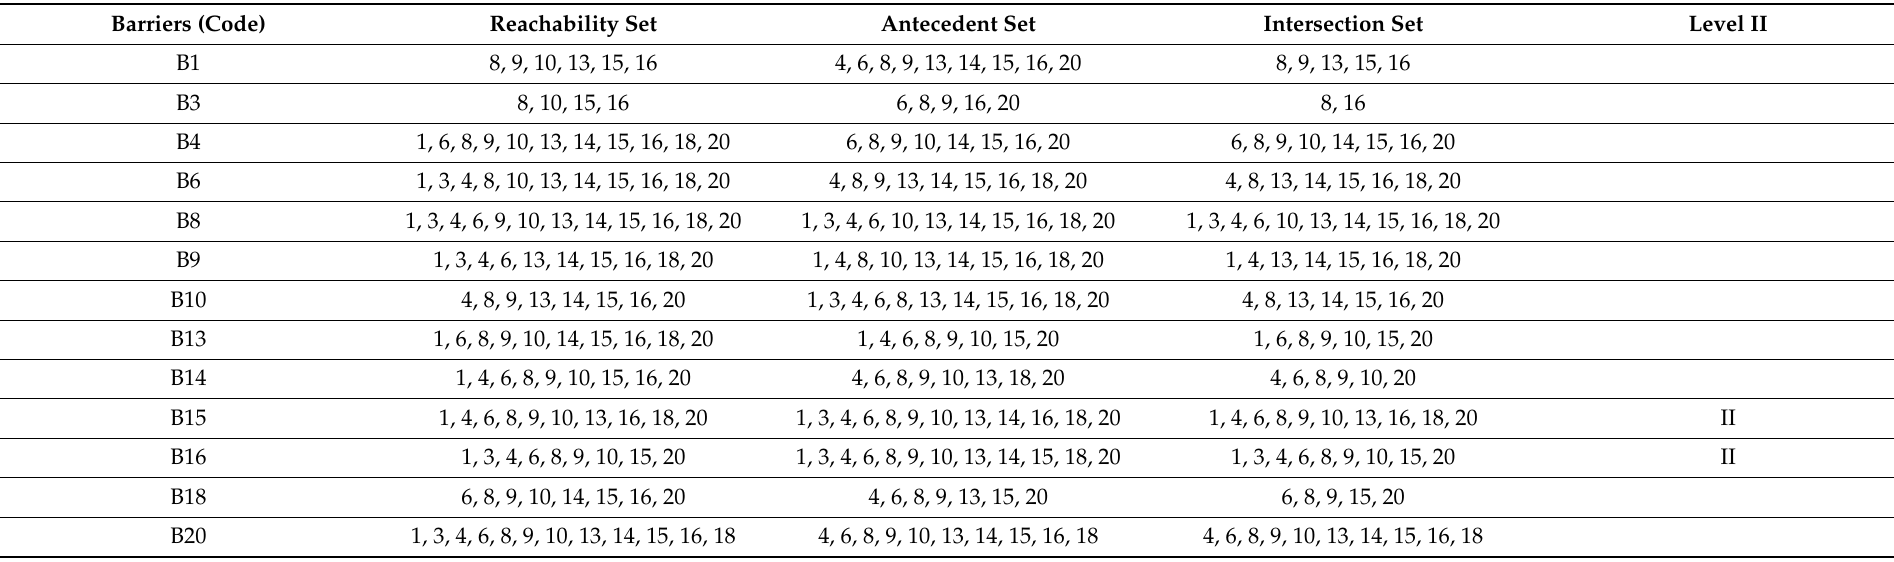
Table 7. RM level partition II.